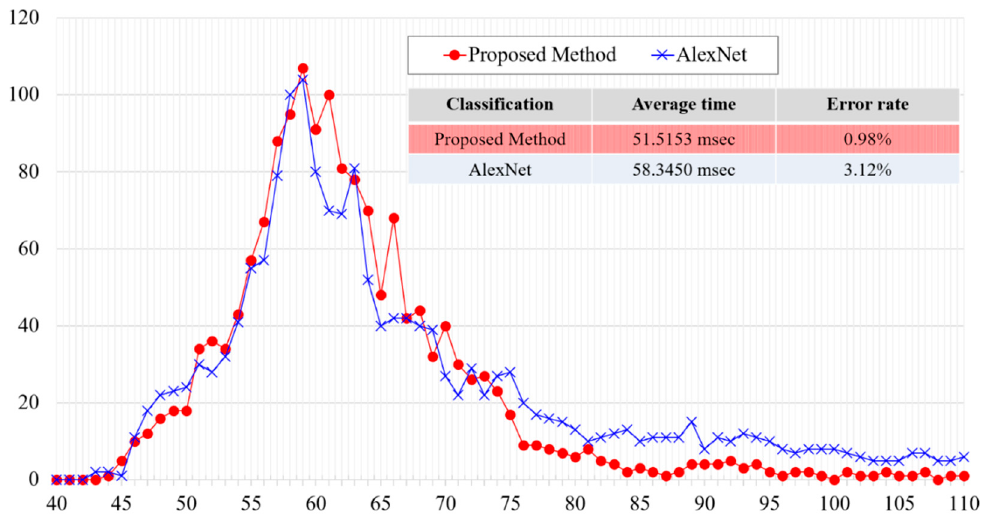
Figure 13. Eye area detection time (in milliseconds).